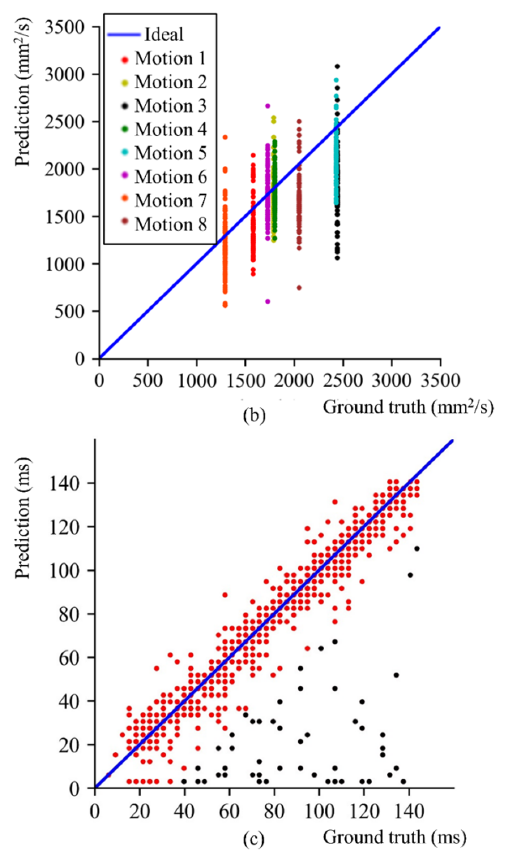
Figure 6. Results of motion feature evaluation. ( a ) Data distribution of maximum opening distance (mm). ( b ) Data distribution of maximum-swept area velocity (mm 2 /s). ( c ) Data distribution of opening time (ms). The black points are outliers that differ significantly from the ground truth, and they account for approximately 6.6% of the total.